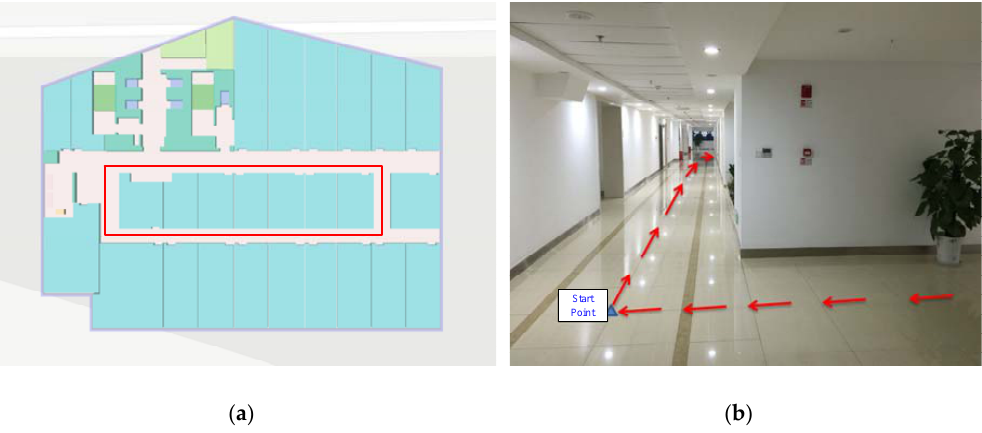
Figure 3. Trajectory of experiment. ( a ) Trajectory profile; ( b ) Experimental environment. Sensors 2018 , 18 , x FOR PEER REVIEW